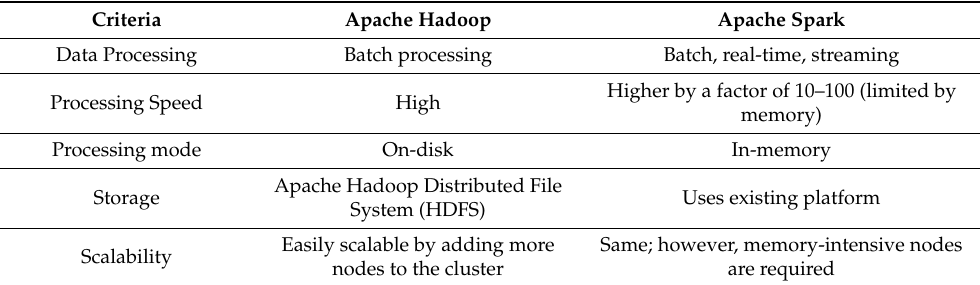
Table 1. Feature comparison between Apache Hadoop and Apache